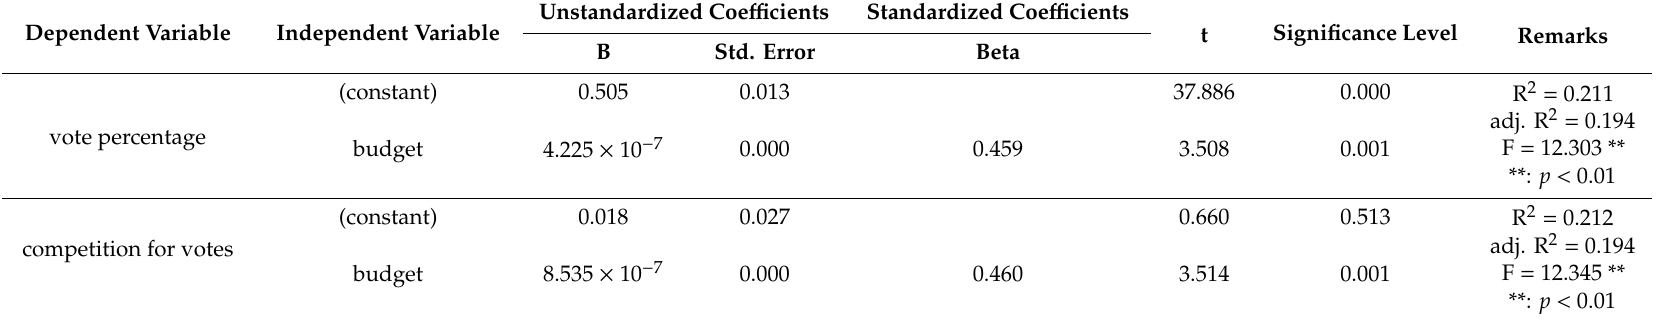
Table 1. The e ff ect of a pledge budget on